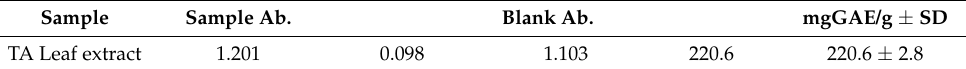
Table 4. Total Phenolic contents